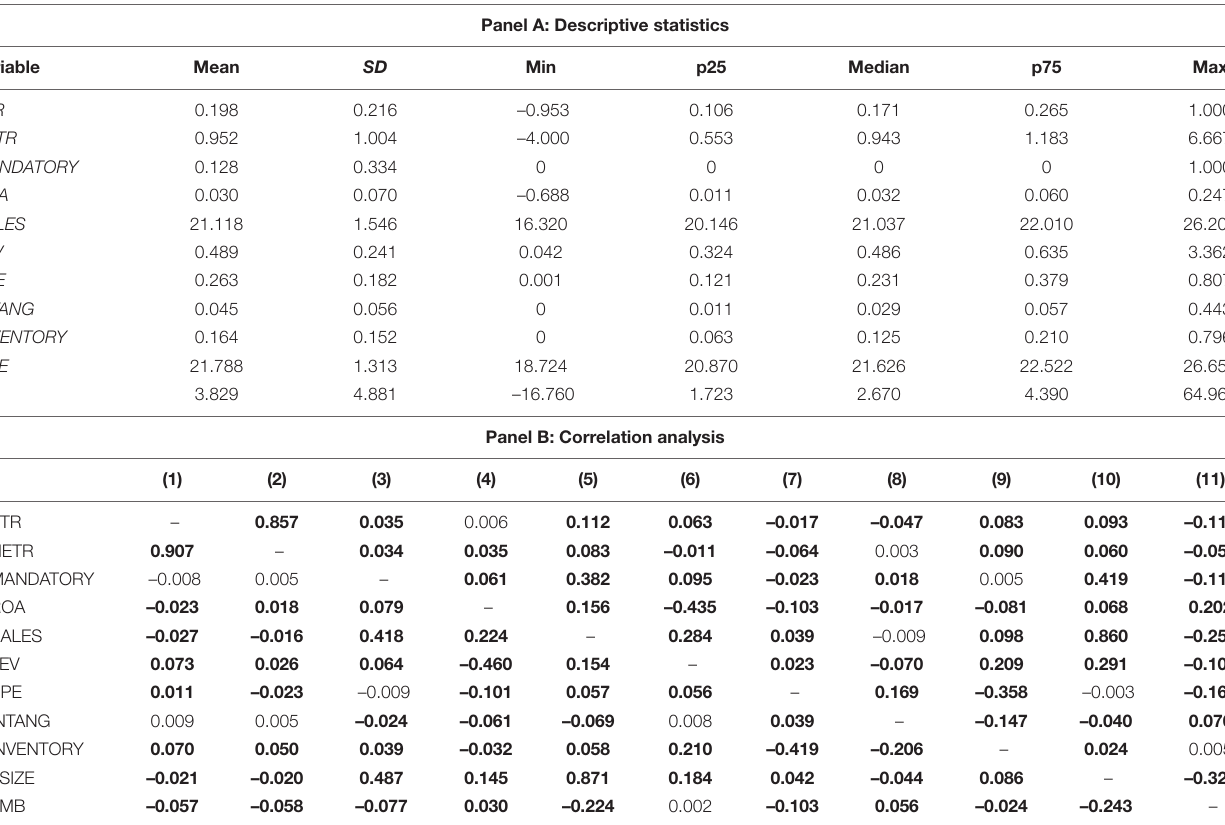
TABLE 1 | Descriptive statistics and